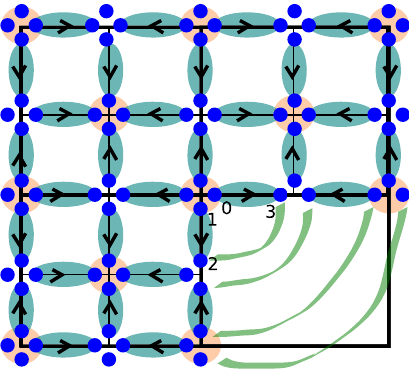
FIG. 11. A 90-degree disclination defect in the Majorana lattice above. The green curves denote Majoranas that are equivalent in the projected Hilbert space (see Appendix C). In particular, c 2 ¼ c 3 ¼ c 0 on the defect Hilbert space. This means that the rightward and downward bonds from the singular vertex combine into a single term − ð i= 2 Þð c 0 þ c 1 Þ c 0 in the Hamiltonian, meaning c 0 − c 1 is an unpaired Majorana zero mode. Likewise, one can show that a 180-degree disclination carries two unpaired Major- ana zero modes. These cannot be paired in a symmetric way. However, we expect that a fusion of four 90-degree disclinations will have four unpaired Majorana zero modes, which can be paired in a C 4 symmetric